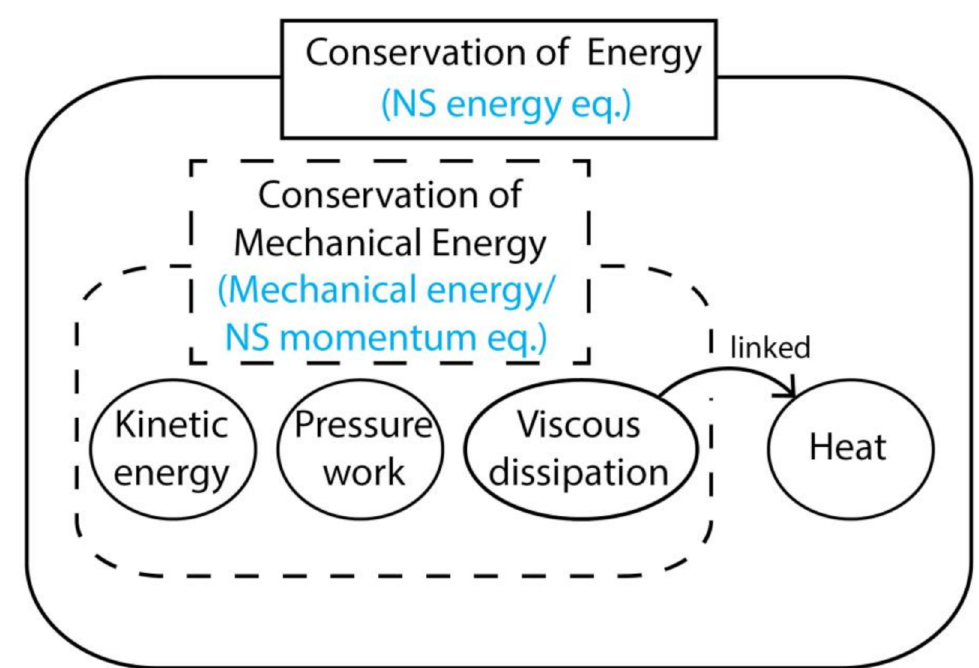
Figure 1. The diagram of the conservation of total energy and mechanical energy [19].